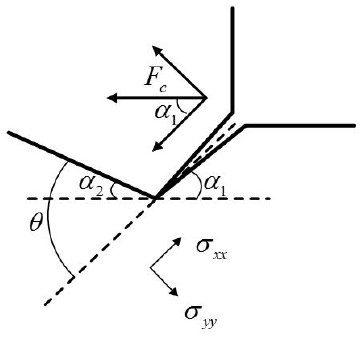
Figure 5. Distribution of Cutting Force in Crack Deflection